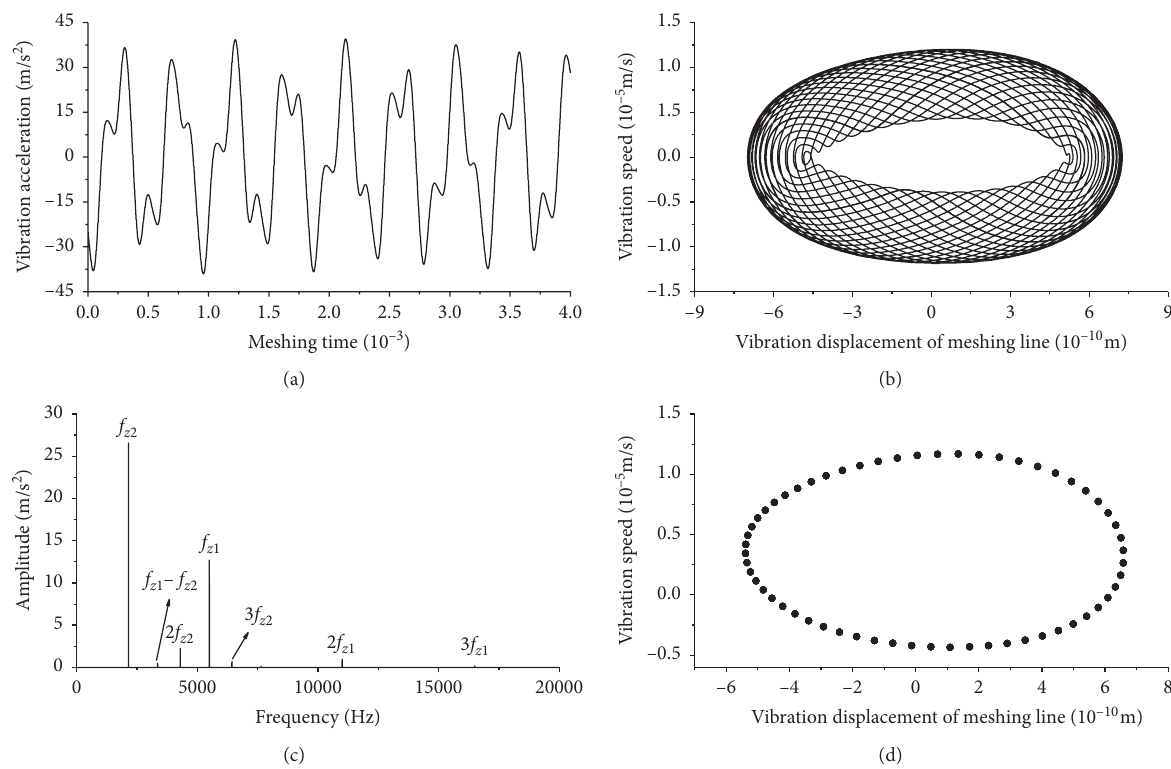
Figure 14: Vibration response of the output-stage gear pair of a two-stage helical gear transmission system at 15,000rpm: (a) time-domain diagram, (b) phase diagram, (c) frequency-domain diagram, and (d) Poincar´e